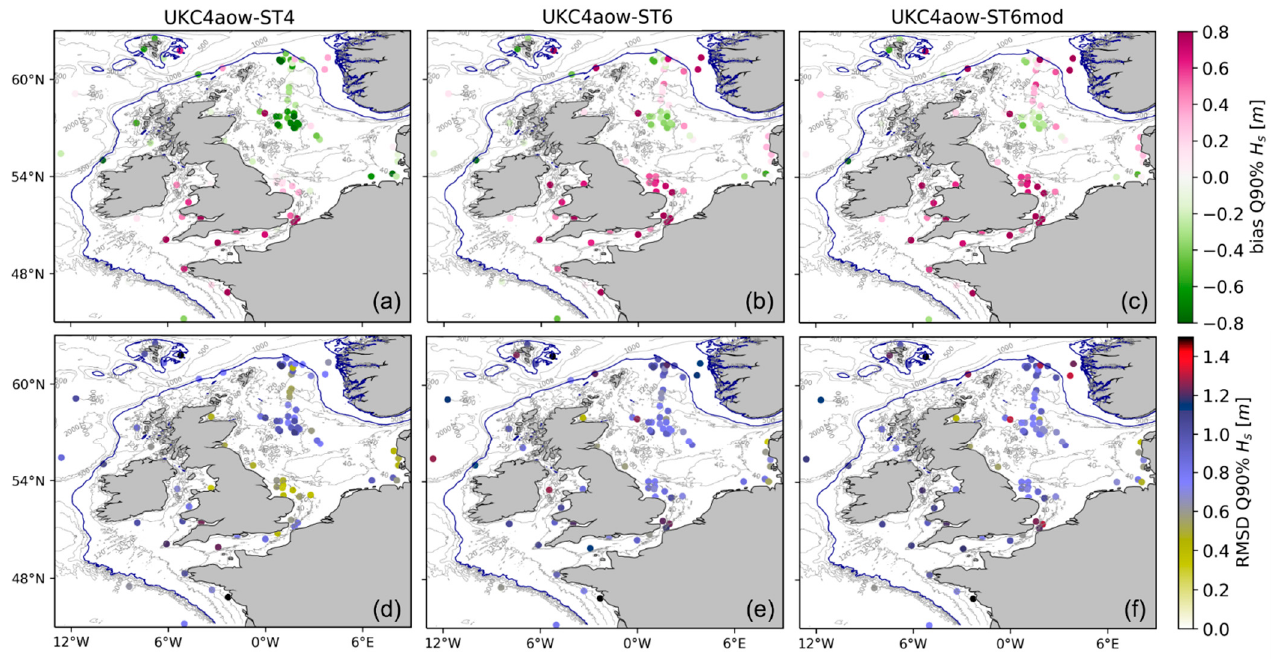
Figure 5. Averaged significant wave height bias ( a – c ) and RMSD ( d – f ) for the quantile of 90% (Q90%) at in-situ locations for the coupled experiments (UKC4aow-ST4, UKC4ow-ST6 and UKC4aow-ST6mod). The 200-m isobath (solid blue contour) is included to indicate the continental shelf limit.